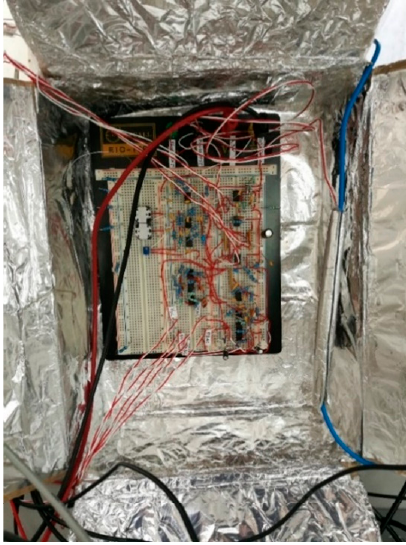
Figure 8. Prototype of the analog front-end with the capacitive probe inside a paper box that is internally coated with silver paper.